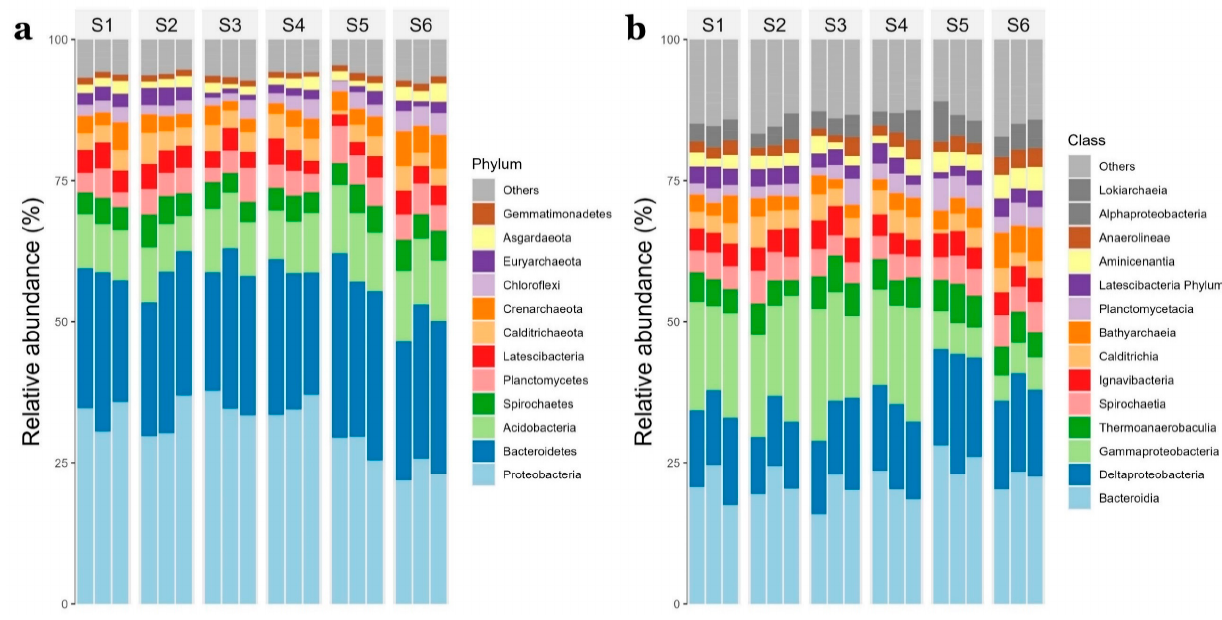
Figure 3. Relative abundance (%) of bacterial and archaeal top phyla ( a ) and classes ( b ). Data are shown for the triplicates of each of the six sampling stations (S1–S6).